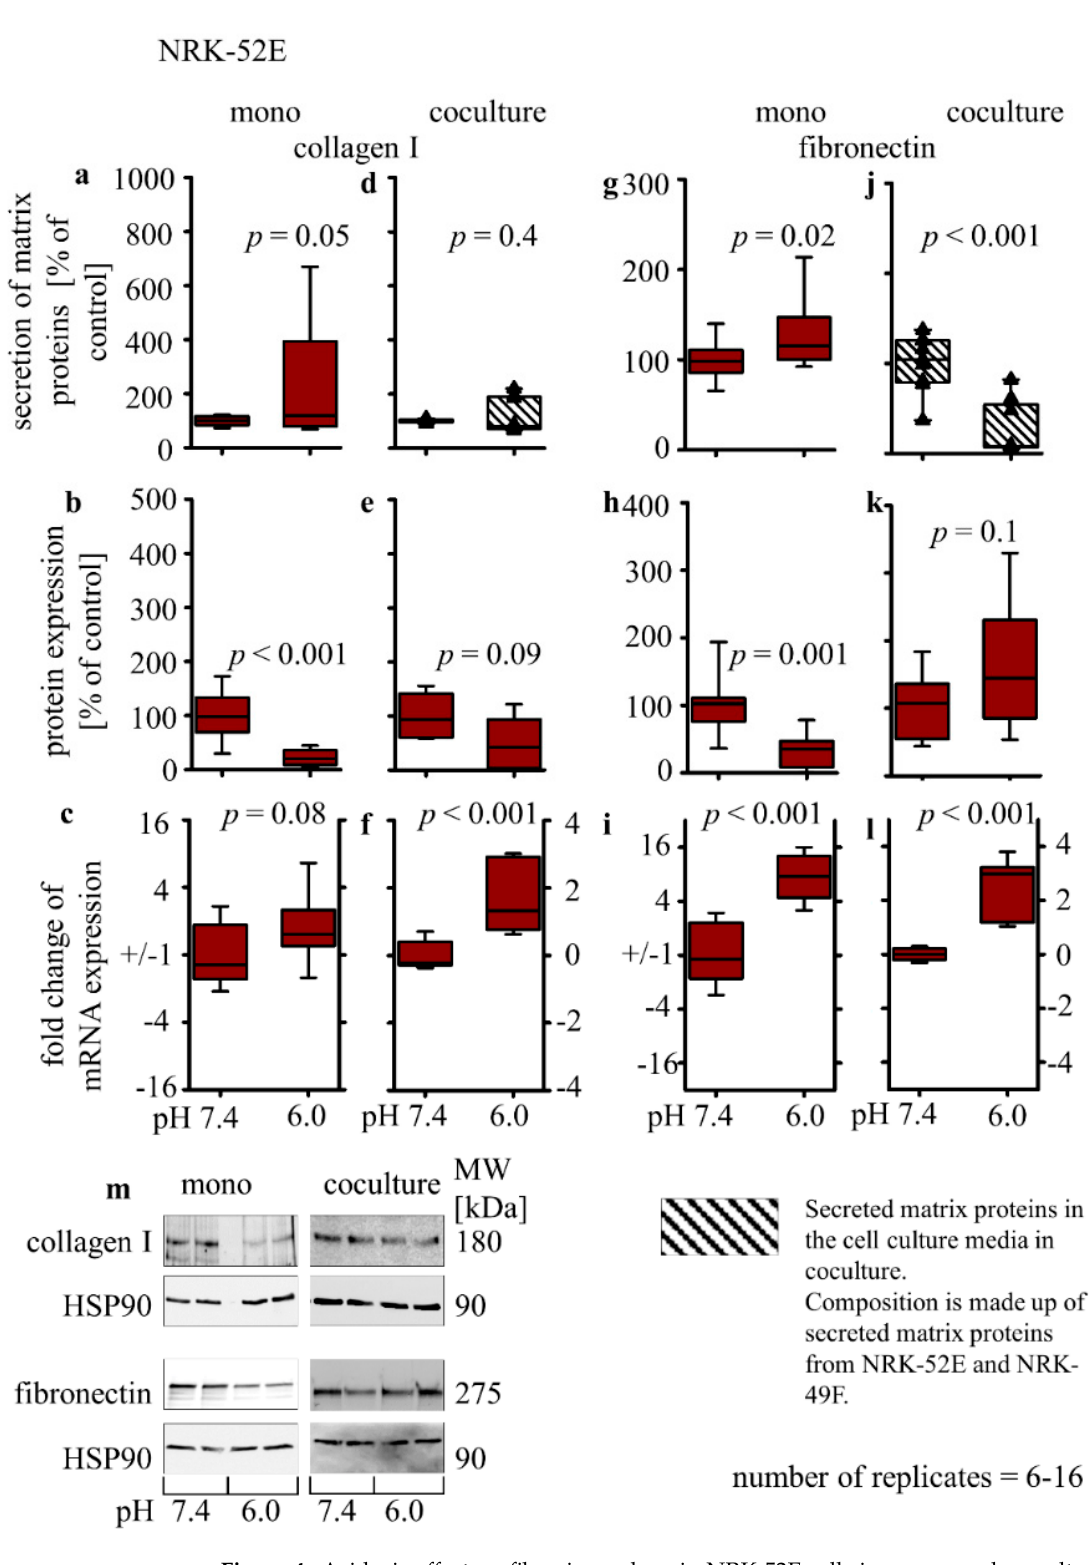
Figure 4. Acidosis effect on fibrosis markers in NRK-52E cells in mono- and co-cultures. Impact of acidosis on the expression of secreted collagen I ( a , d ) and fibronectin ( g , j ). Intracellular protein expression changes of collagen I ( b , e ) and fibronectin ( h , k ) as well as relative changes of collagen I ( c , f ) and fibronectin ( i , l ) mRNA expression. ( m ) Representative Western blots of proteins isolated from cells exposed to acidosis. p < 0.05 at significant difference compared with the control group; n − (6 − 16). Exposure time = 48 h. The effect of acidosis on secreted collagen I and fibronectin in co-culture cannot be assessed for the two cell types separately. Therefore, the assessment of the contribution of only an individual cell type is not possible. Under co-culture conditions, exposure to acidic media had no impact on total extracellular collagen I but led to a decrease in total extracellular fibronectin (26% ± 10; p < 0.01) (Figure 4d,j). The intracellular protein amount of collagen I or